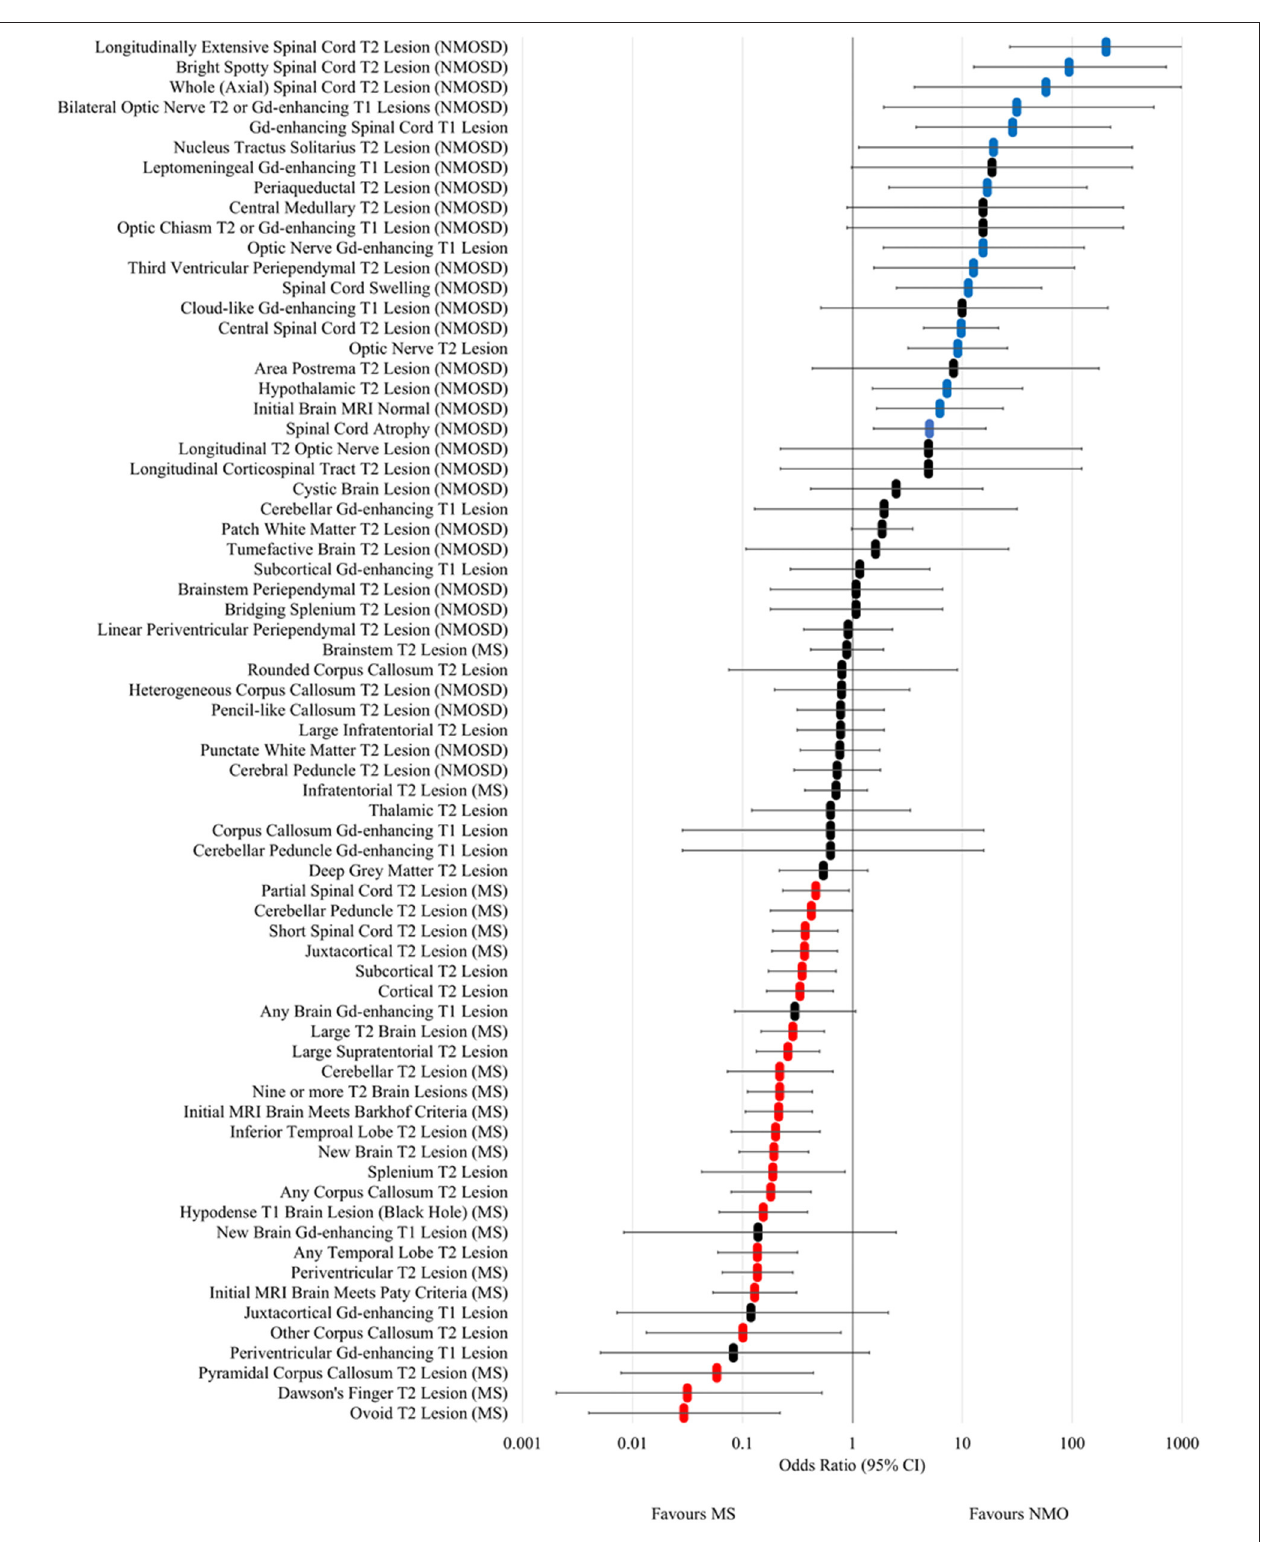
FIGURE 4 | Forest plot of odds ratios for lesion occurrence in NMOSD and multiple sclerosis. OR > 1 favour NMOSD and OR < 1 favour multiple sclerosis. Error bars indicate 95% confidence intervals. Lesions significantly associated with NMOSD are highlighted in blue and those associated with multiple sclerosis are highlighted in